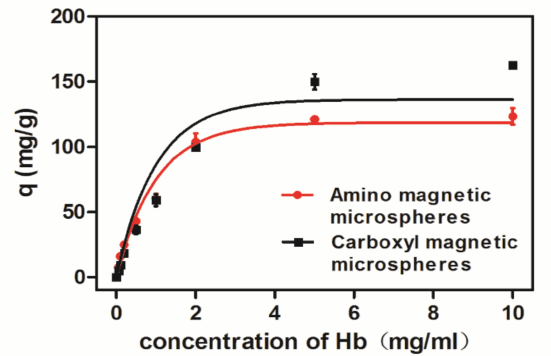
Figure 7. Adsorption isotherm of magnetic microspheres on Hb at 25 ◦